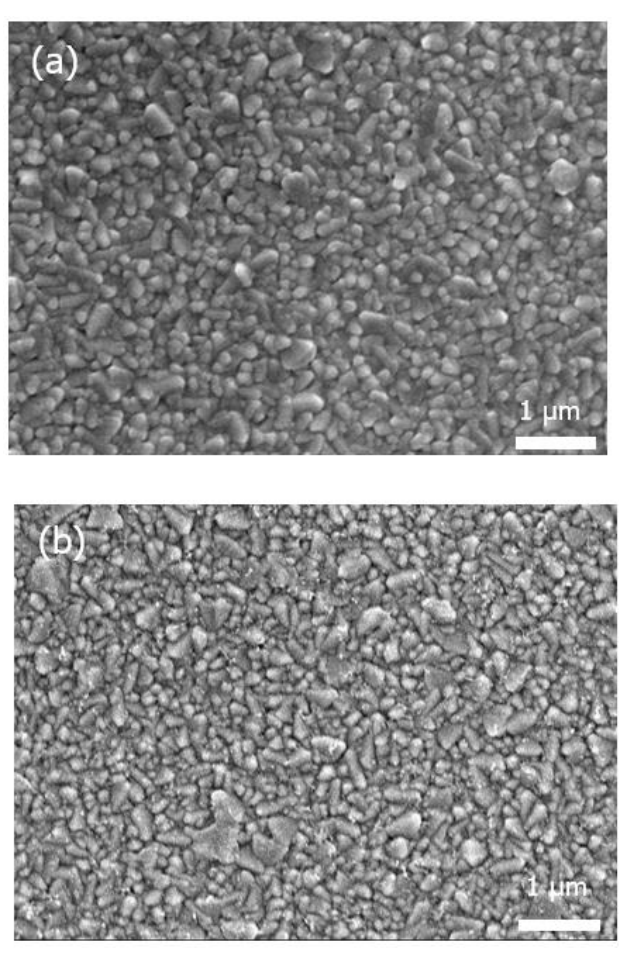
Figure 2. Photographs of FE-SEM observation of TiO 2 layer fabricated by ( a ) electron-beam evapo- ration, and ( b ) chemical bath deposition method.